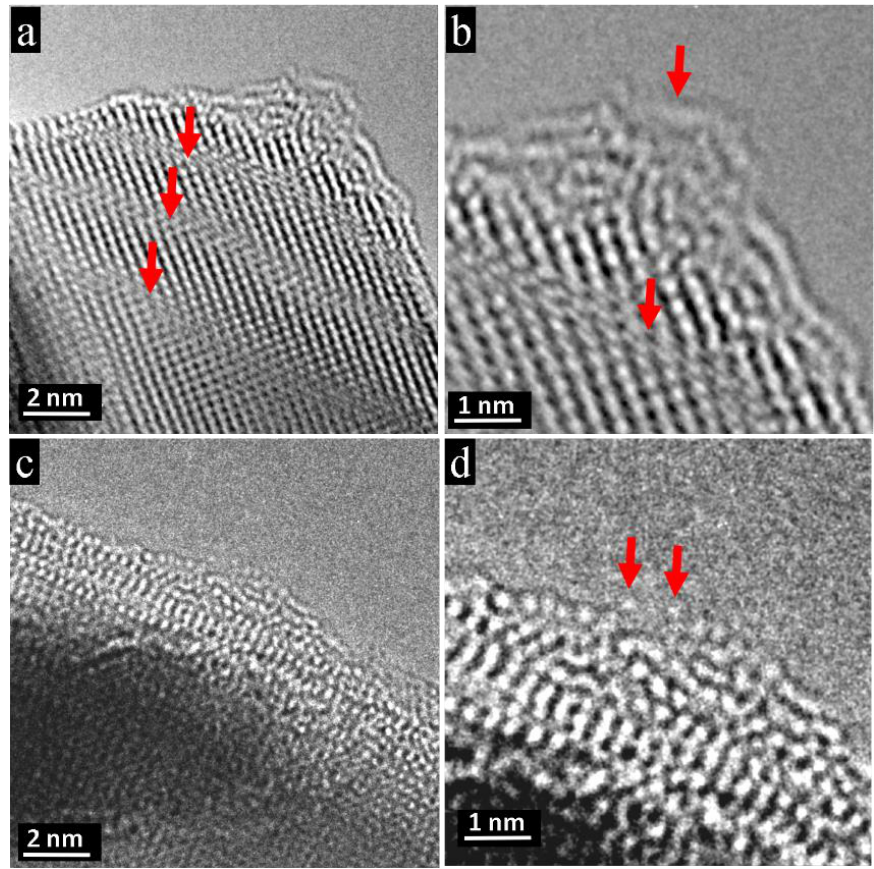
Figure 9. Degradation mechanism at atomic level revealed on outermost PbTe atomic layers obtained by electron-beam treatment of the single crystalline PbTe. ( a ) Degradation is manifested by atomic steps, in this case along the [110] direction, showing layer-wise depletion, see red arrows. ( b ) The corners are the most energetically unstable places where disintegration of atomic rows occurs. ( c ) Corrugated uppermost atomic layers. ( d ) Magnification reveals the atomistic degradation mechanism. An atom is removed from the very top from the necklace-like atomic row, leaving two open ends of atomic chains marked by red arrows.